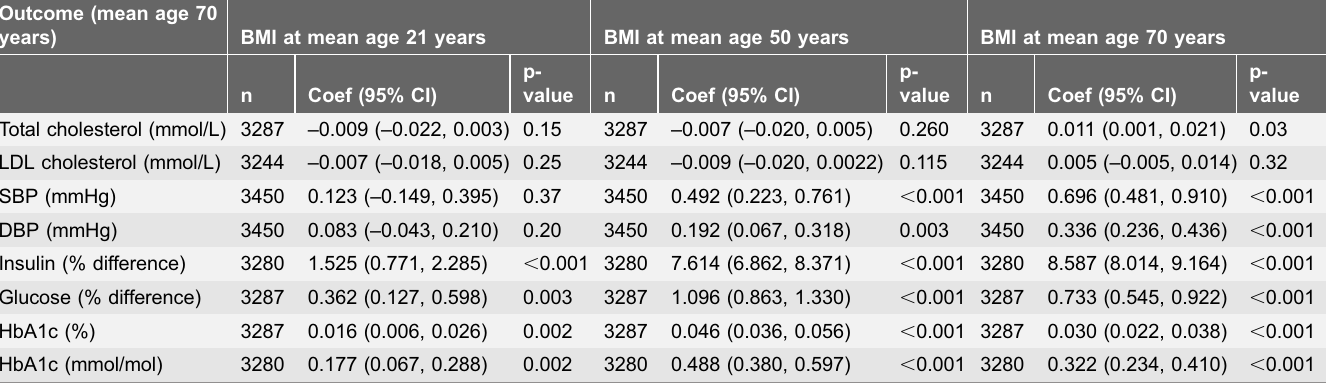
Table 2. Differences in cardiovascular and diabetes risk markers at mean age 70 years for each 1 kg/m 2 increase in BMI separately at mean age 21, 50 and 70